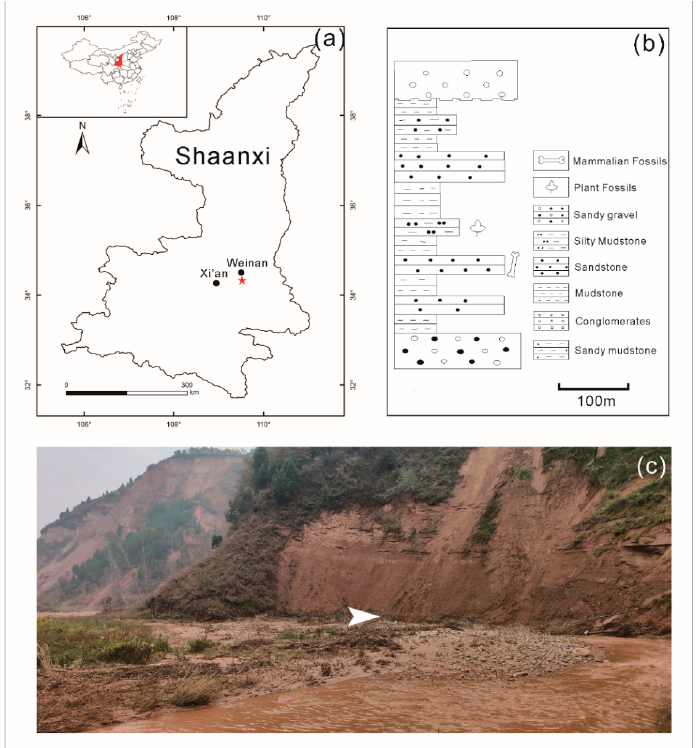
Figure 1. Fossil site in Yangguo Town, Weinan City, Shaanxi, central China. ( a ) The location of the fossil site. The red star represents the locality of fossil collection; ( b ) Fossil collection horizon and lithology of the Bailuyuan Formation, based on Li [37], the mammalian fossils are based on [44,45]; ( c ) The outcrop of the fossil site (white arrow).